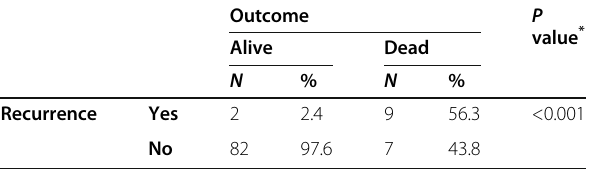
Table 5 Percentage of dead patients with HCC recurrence from all dead